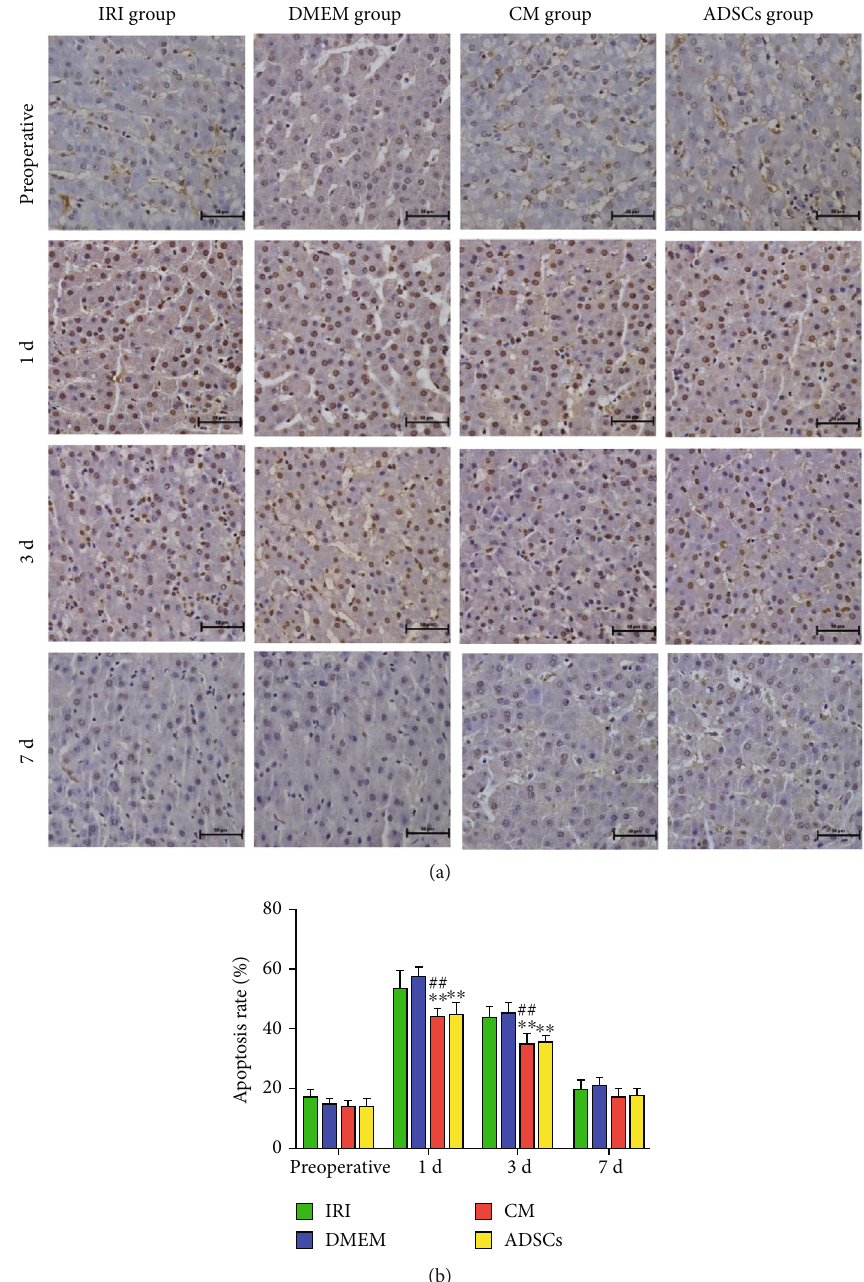
Figure 2: Hepatocyte apoptosis rates: (a) representative images of TUNEL-stained liver tissues from the indicated groups and at the indicated time points (magni fi cation 400x); (b) apoptosis rate of hepatocytes. ∗∗ P < 0 : 01 compared to IRI group and ## P < 0 : 01 compared to DMEM